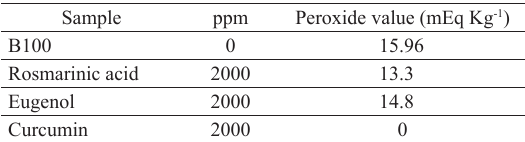
Table 5. Peroxide values in pure biodiesel sample (B100) and samples with additives.